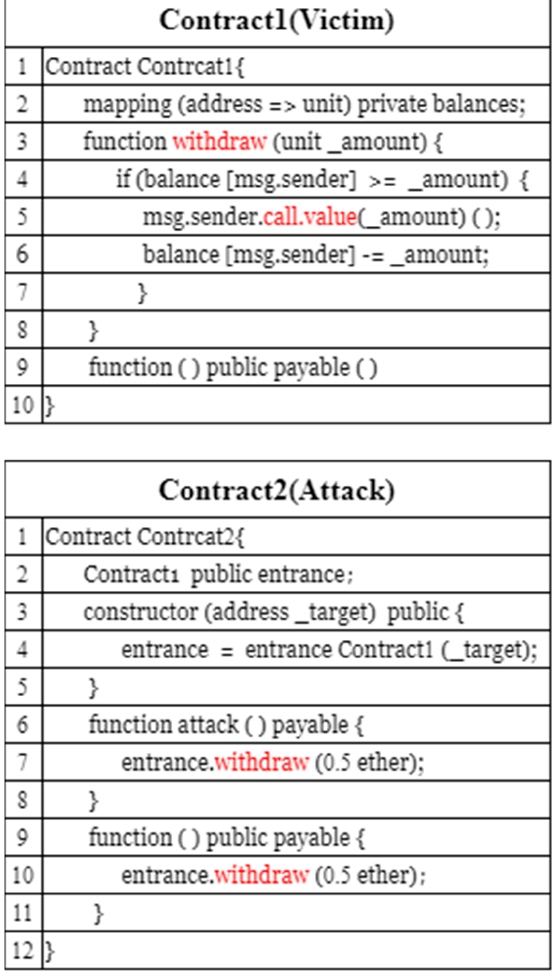
Figure 3. A real-world instance of smart contract reentrancy attack.